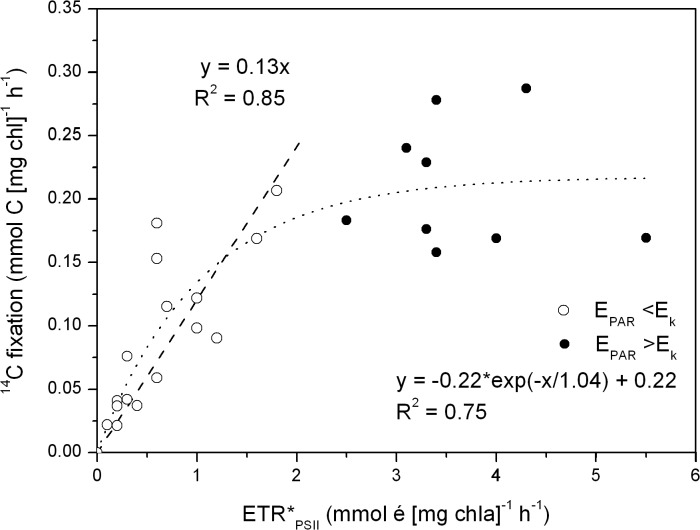

14C fixation versus electron transfer rate (ETR*PSII).
14C fixation rates versus absolute rates of ETR*PSII based on four short-term (2h) incubation experiments in a light gradient (0–600 μmol photons m−2 s−1). The dashed line is a linear regression of data for EPAR <Ek (open circles), and the slope coefficient represents the fixation of carbon to electron transfer in mol C (mol é)−1, corresponding to an electron requirement of 7.6 ± 0.6 mol é (mol C)−1. The complete data set expressed a non-linear relationship and is fitted with a simple inverted exponential decay function (dotted line, R2 = 0.75).